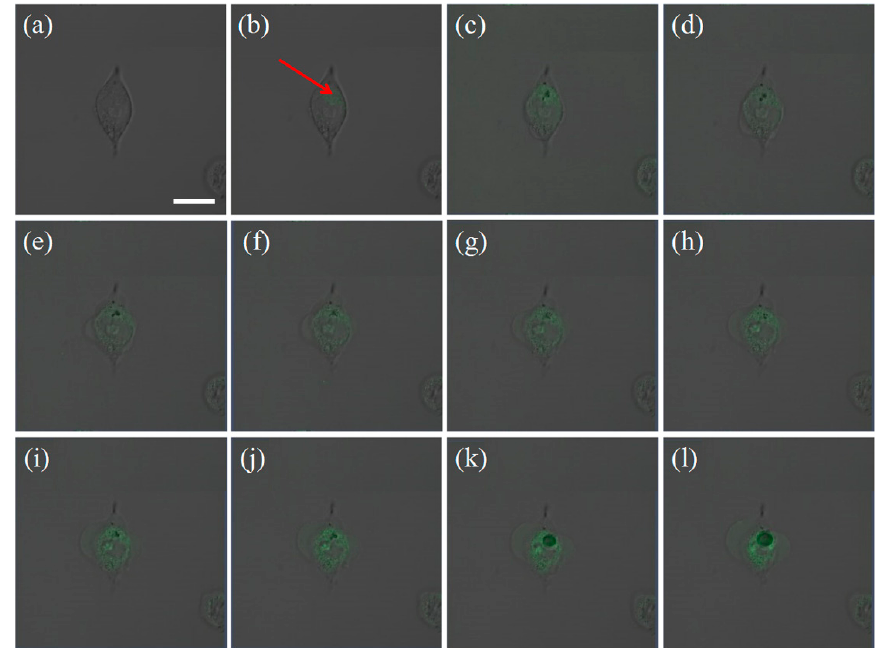
Figure 4. The image of an A375 cell incubated with GNRs for 24 h. ( a ) The bright field image before the laser treatment; ( b ) the combination of the bright field image and two-photon-absorption induced luminescence (TPL) emission image of the cell before laser treatment; ( c )–( l ) evolution of the cell morphology and TPL image of the excited GNR cluster when the cell was exposed to the fs laser light for different time periods of 0.1, 0.2, 0.3, 0.4, 0.5, 0.6, 0.7, 0.8, 0.9, and 1.0 s, respectively. It can be seen that afer laser treatment bubbles appears near the point of action ,with the accumulation of action time the bubbles in the cells became larger. The length of the scale bar is 20 μ m.